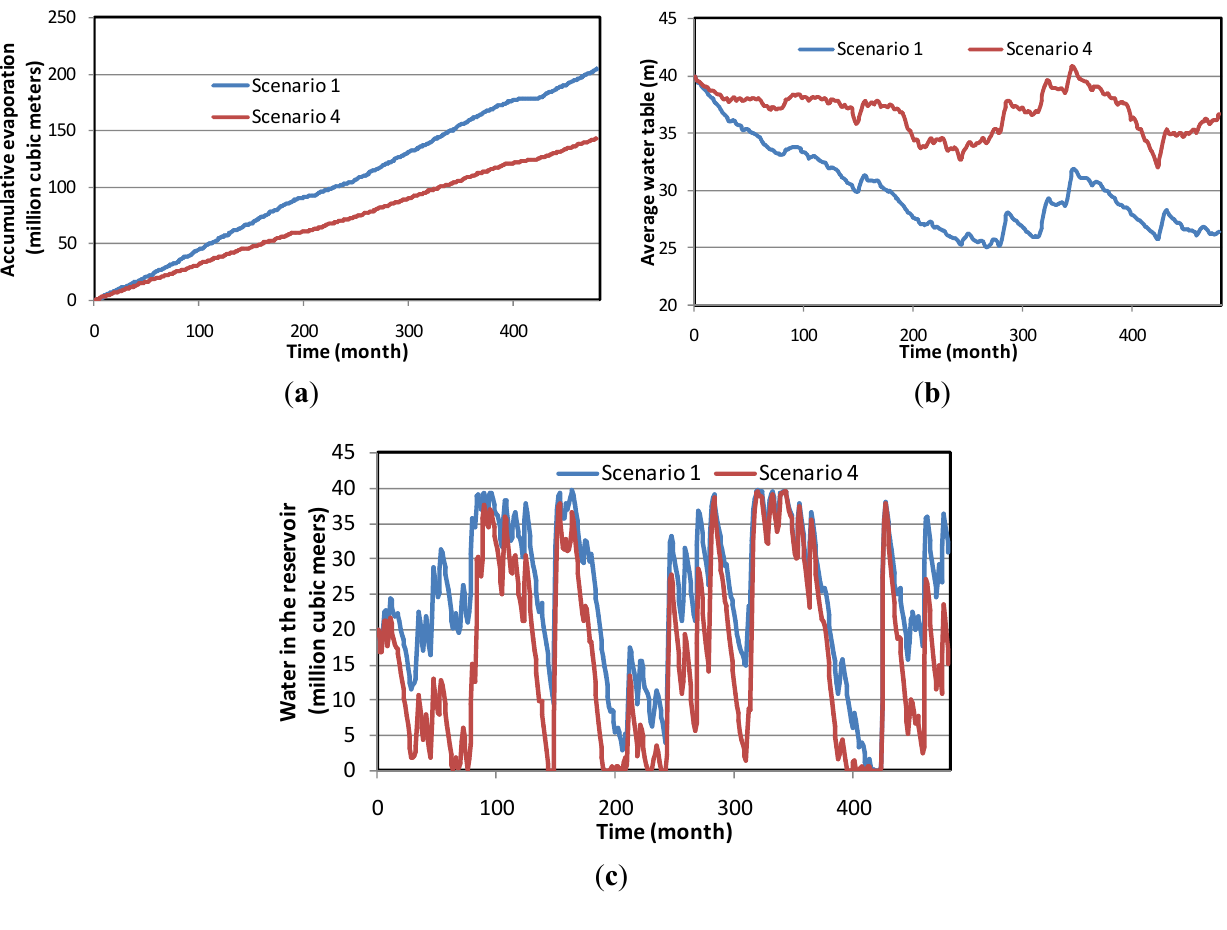
Figure 12. Models results for Scenarios 1 and 4: ( a ) accumulative evaporation; ( b ) average water table of the aquifer: and ( c ) water storage in the